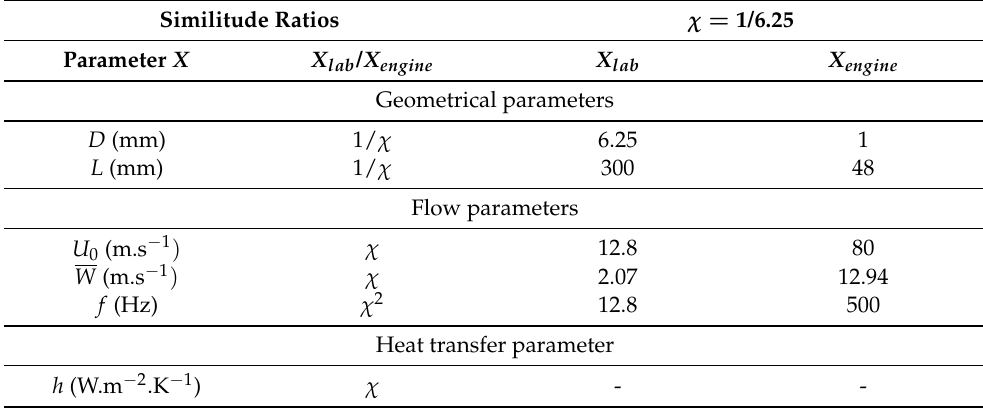
Table 2. Similitude ratios between the lab and engine